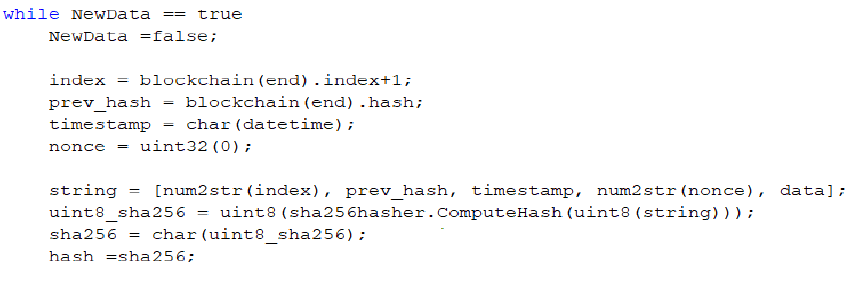
Figure A5. The code used in data validation.